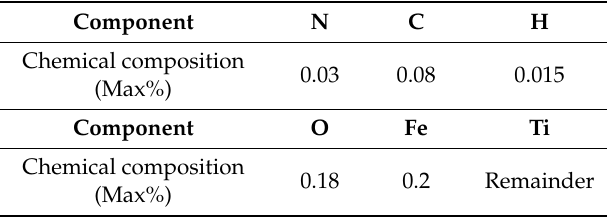
Figure 3. Schematic view of rotating magnetic field generator for beta-titanium wire: ( a ) 3D view of rotational magnetic field device and ( b ) 2D dimensional view of the rotational magnetic field device.